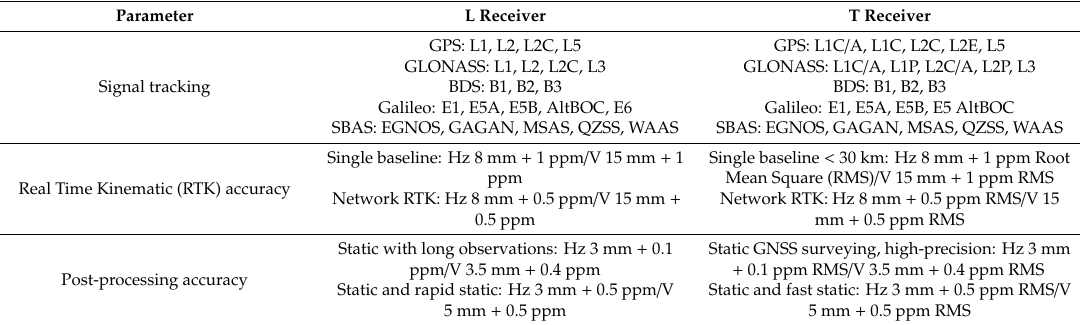
Table 1. The technical details of the GNSS receivers used in the study.